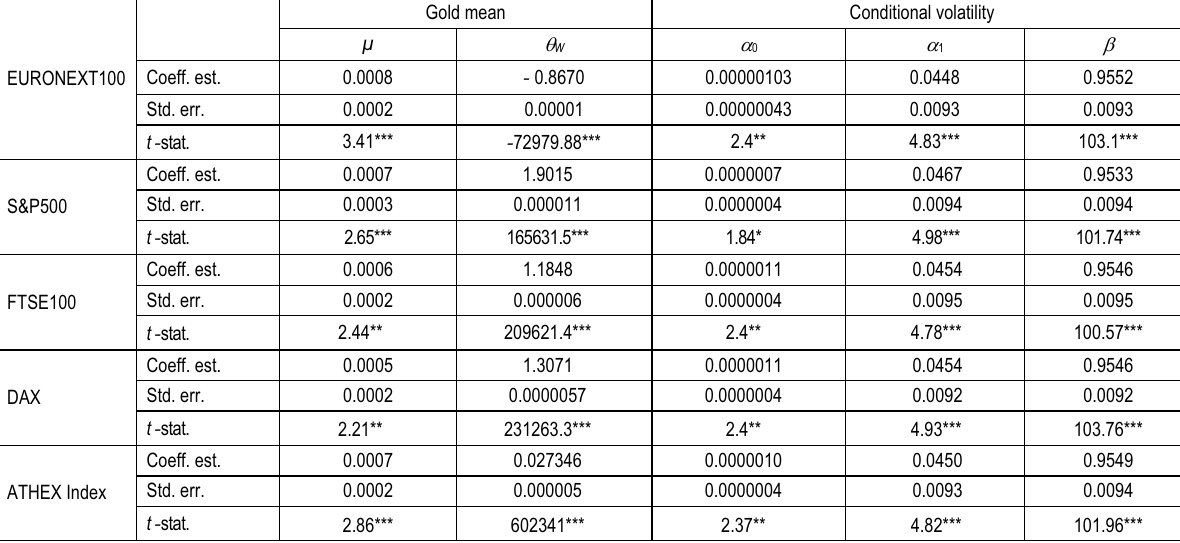
Table 3. Estimation results for stock market indices Results of GARCH-X (1,1) model with mean equation of gold returns depending on stock markets volatility.